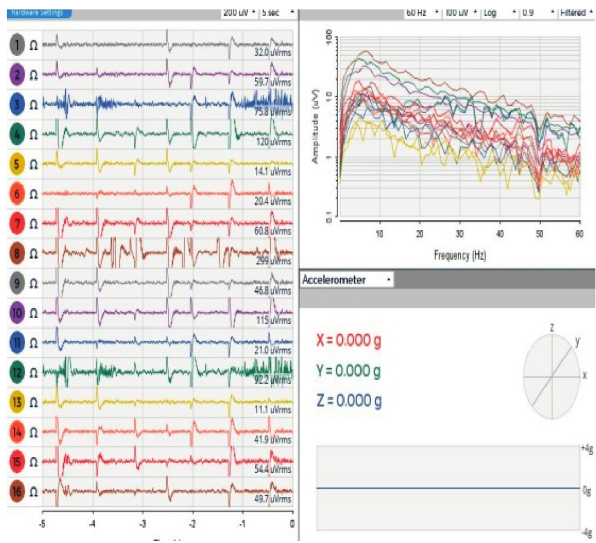
Figure 9: The EEG of push action idea in the dynamic state.